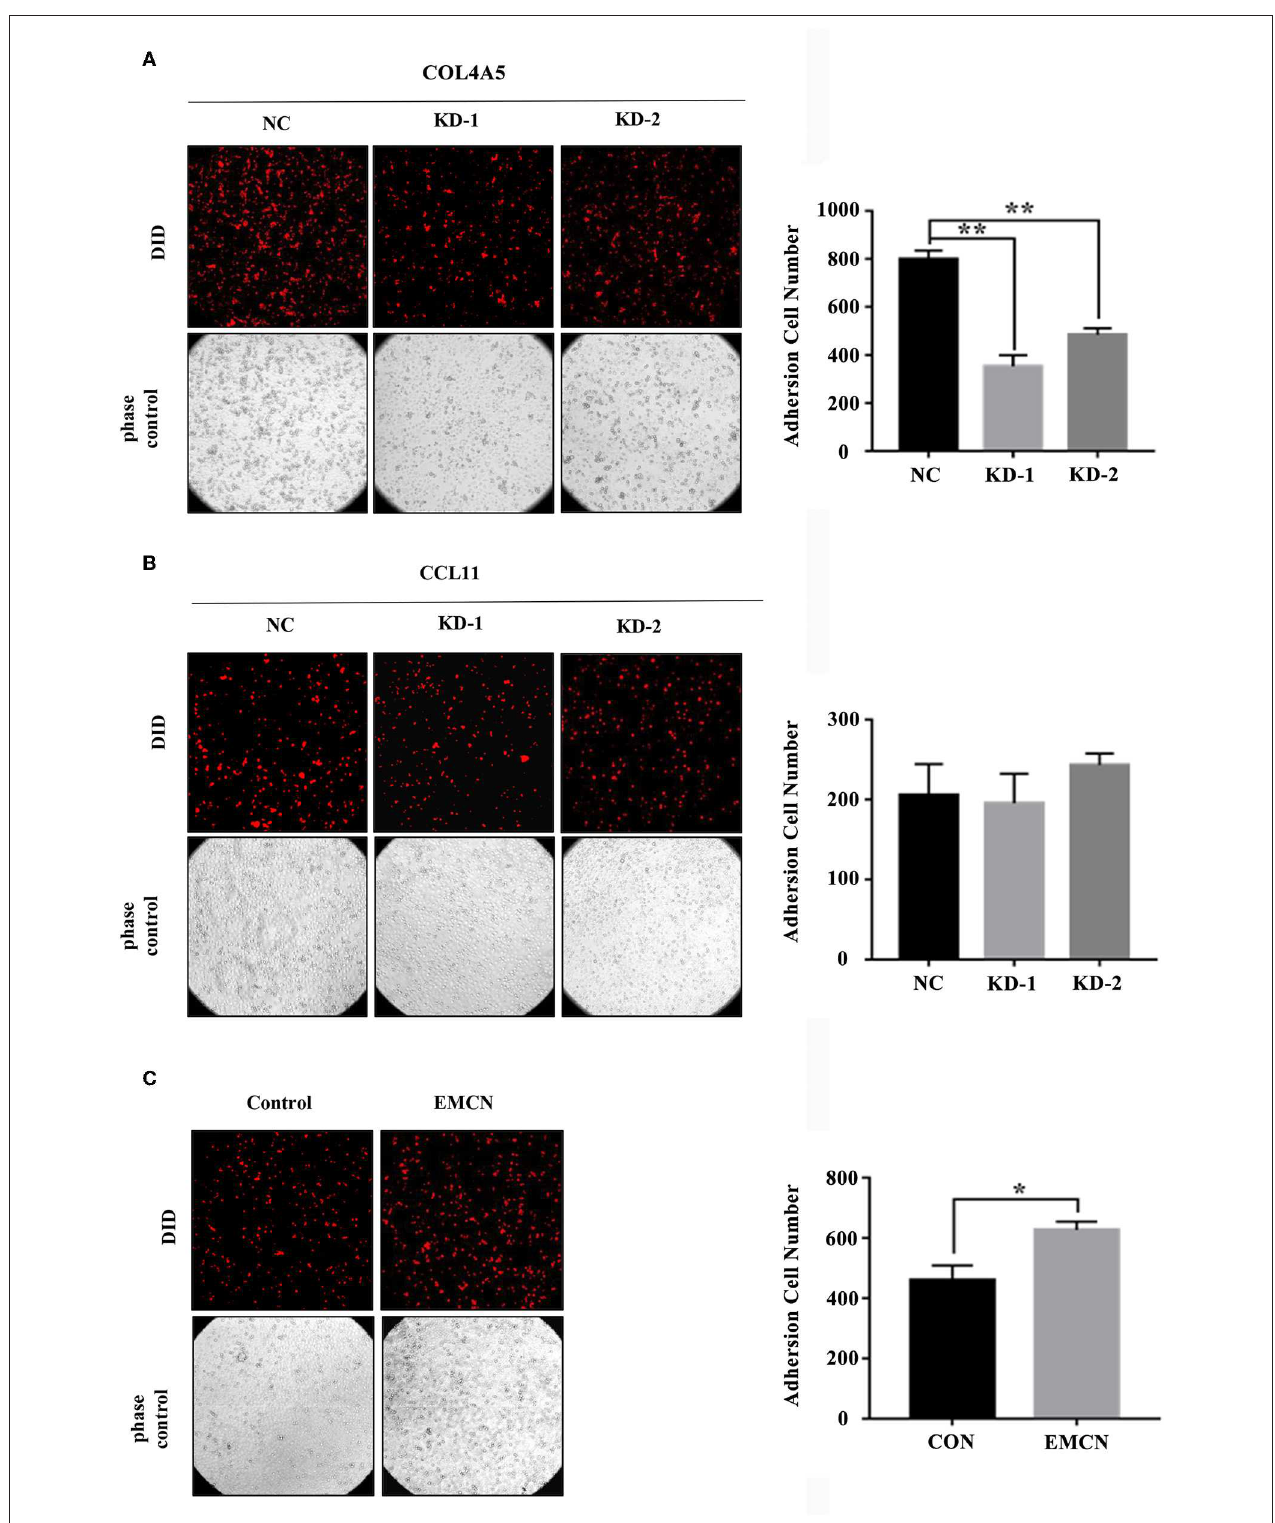
FIGURE 5 | The effect of COL4A5, CCL11, and EMCN on the adhesion ability of diffuse type GC cells on peritoneal mesothelial cells. After transfected with siCOL4A5 (A) or siCCL11 (B) , or treated with EMCN (C) , the adhesion ability of MKN45 cells on HMR-SV5 cells was observed by Light microscopy. The columns on the right represent the cell numbers by counting three fields, and error bars represent the mean ± SD of three independent experiments. * P < 0.05; ** P < 0.01.